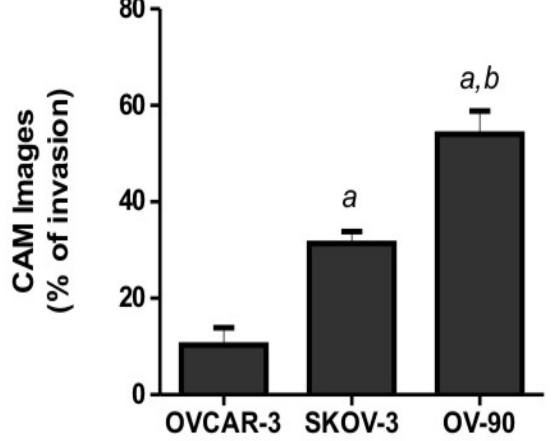
Figure 4. Chick chorioallantoic membrane (CAM) invasion by ovarian cancer cells in day 14 chick embryos. Data generated from 48–60 images from 6 chicken embryos per cell line. Data represents the percentage of images with invasion into the mesoderm, mean ± SEM from two independent experiments. ( a ) Indicates significant difference from OVCAR-3 cells; and ( b ) indicates significant difference from SKOV-3 cells, p < 0.05.